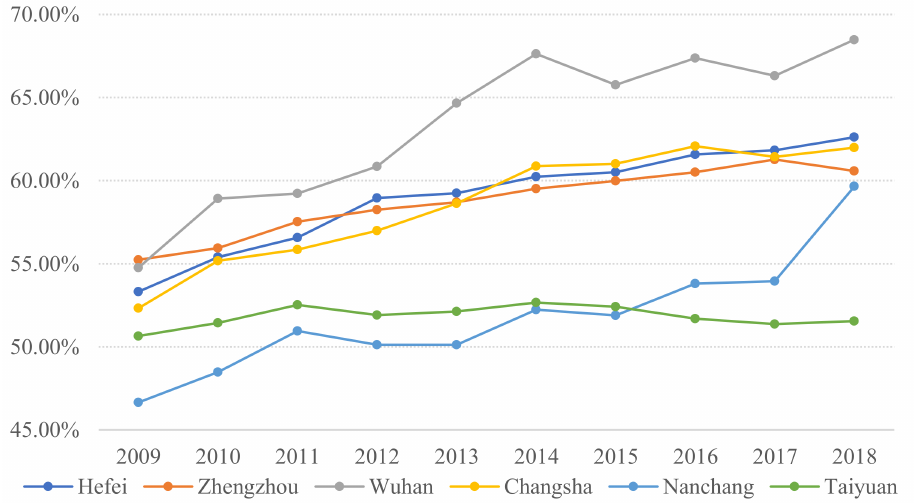
Figure 1. Comparison of in situ urbanization rates among capital cities in six